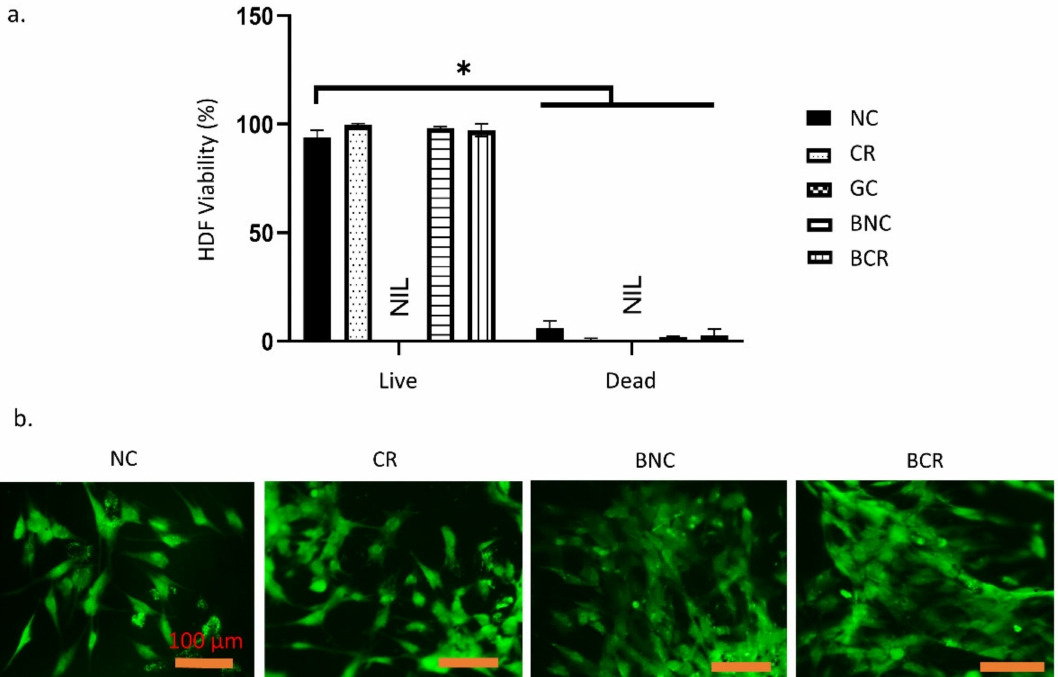
Figure 7. The cellular compatibility of the scaffolds with human dermal fibroblasts after 24 h incubation at 37 ◦ C. ( a ) The cell viability quantification of human dermal fibroblasts using Live and Dead assay and ( b ) the morphology of the human dermal fibroblasts on the fabricated scaffolds, which primarily presented spindle-like cells. * p < 0.05 indicates the siginificant differences of the fabricated